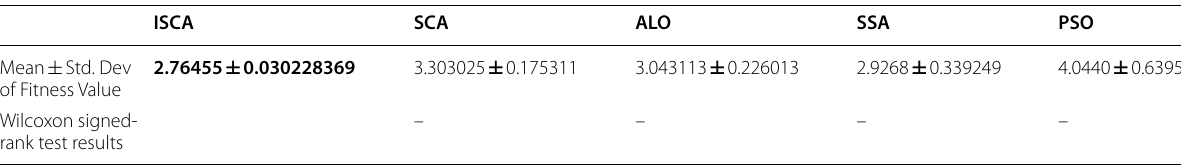
Table 9 Comparison of fitness values and WRST results of the three-area system with physical constraints with SLD of 1% in area-1 using Different Optimization Techniques (Values in bold shows best value)